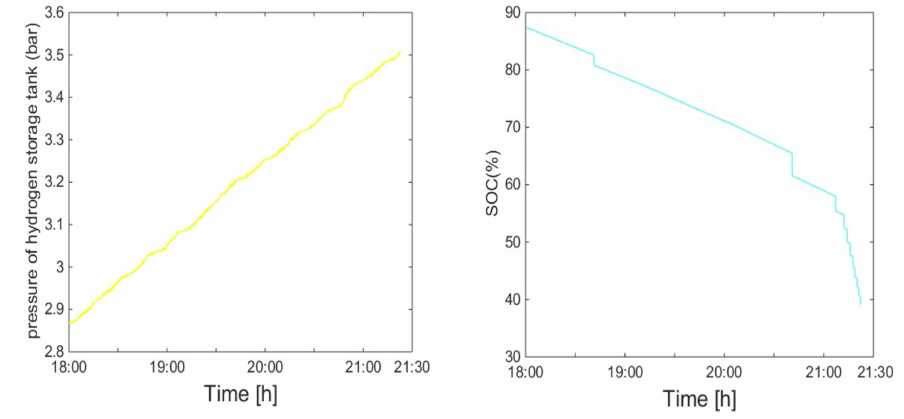
Figure 18. Operation state curves in scenario